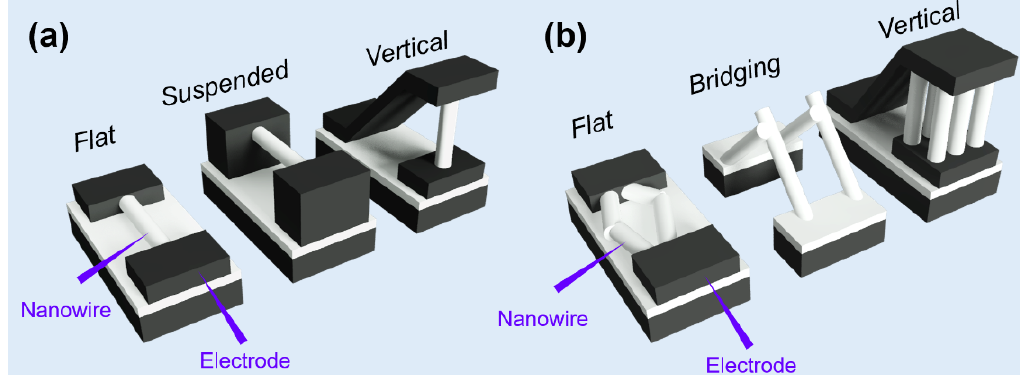
Figure 11. Schematic image of ( a ) an individual nanowire device with different structures (flat, suspended, and vertical); and ( b ) multiple nanowire device (flat, bridging, and vertical).